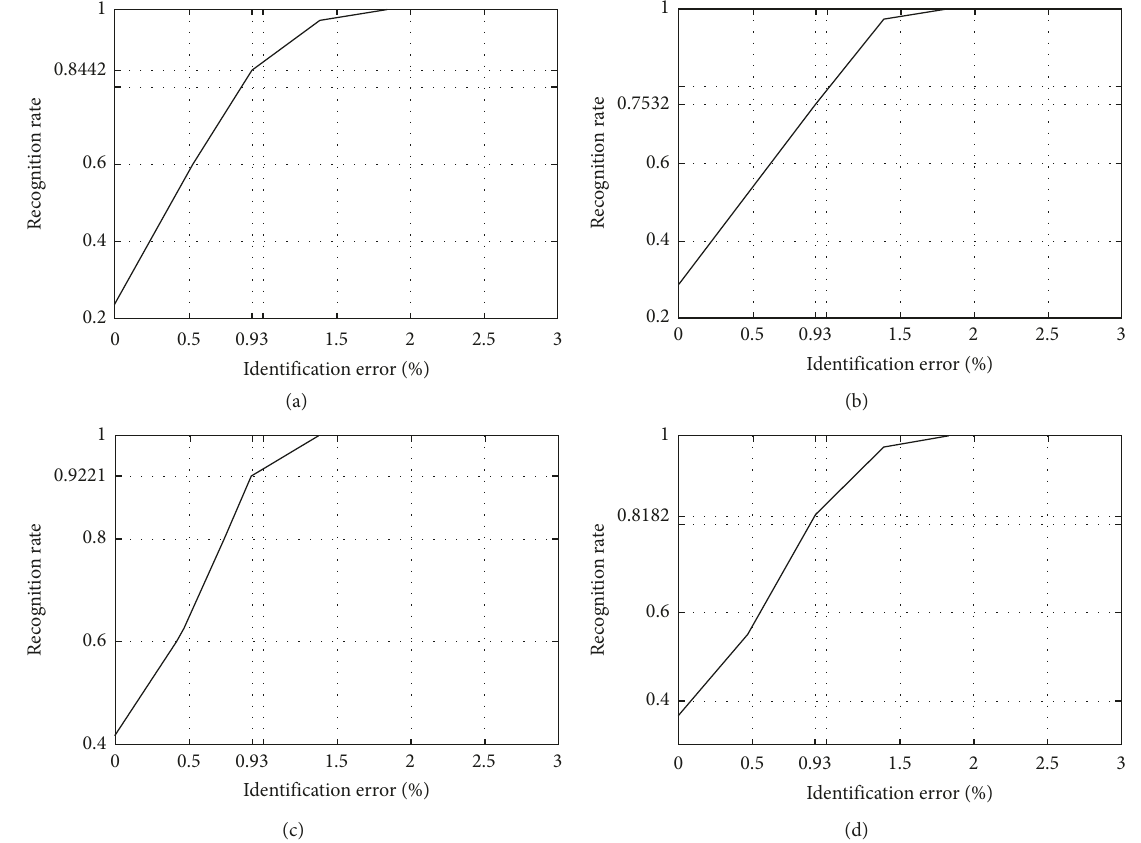
Figure 16: MFL defect feature recognition rate of BP network different nodes: the hidden layer has (a) 10 nodes, (b) 12 nodes, (c) 14 nodes, and (d) 17